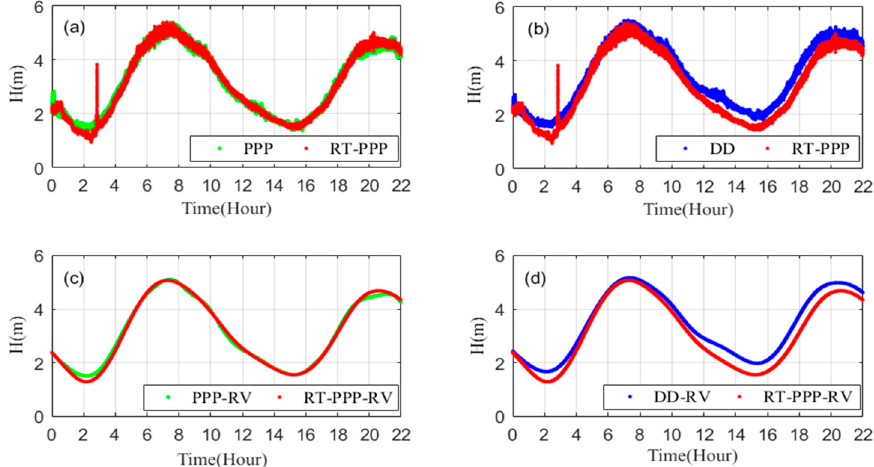
Figure 9. The location of study area near Qingdao, China. A is the fixed reference GPS station, B is the multi-function buoy, and C is the long-term tide gauge station.